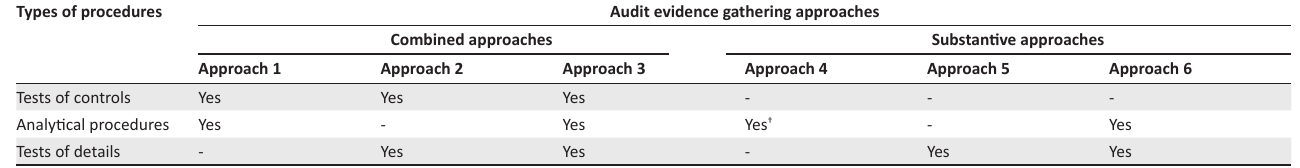
TABLE 1: Audit procedure